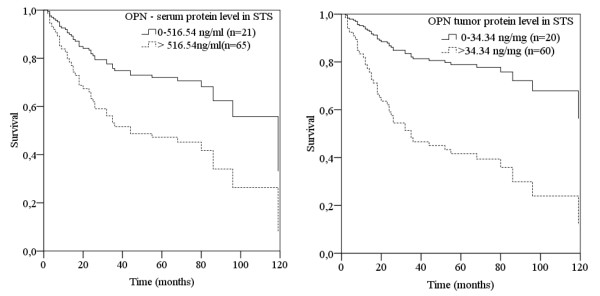
Serum and tumor OPN protein levels and overall survival of STS patients. Analysis of serum (left) and tumor (right) OPN protein levels and overall survival of STS patients using a univariate Cox's proportional hazard regression model. In comparison to patients with a low serum or tumor OPN-level (dotted line), an elevated OPN-level (bold line) correlates with a 2.2- (p < 0.05) or 3.7-fold (p = 0.01) increased risk of tumor-related death for STS patients.